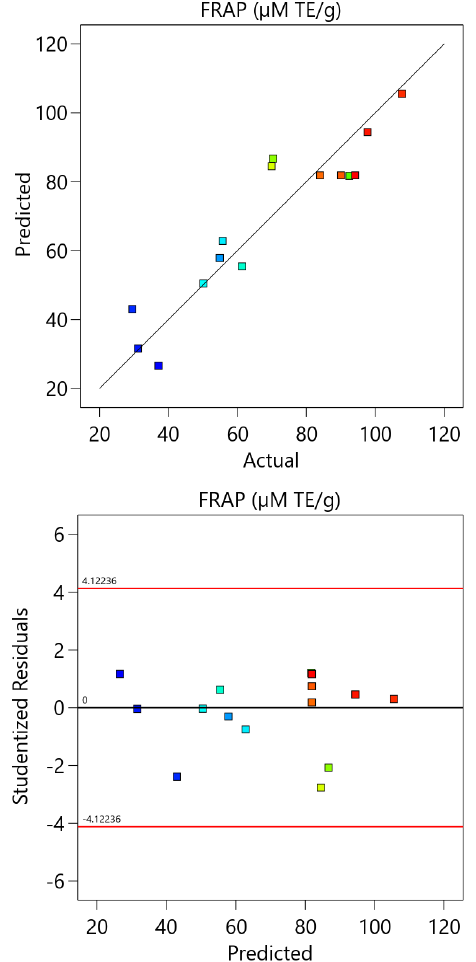
Figure A3. The comparison between the experimental and the predicted data and the residual analysis for the optimization of FRAP test.